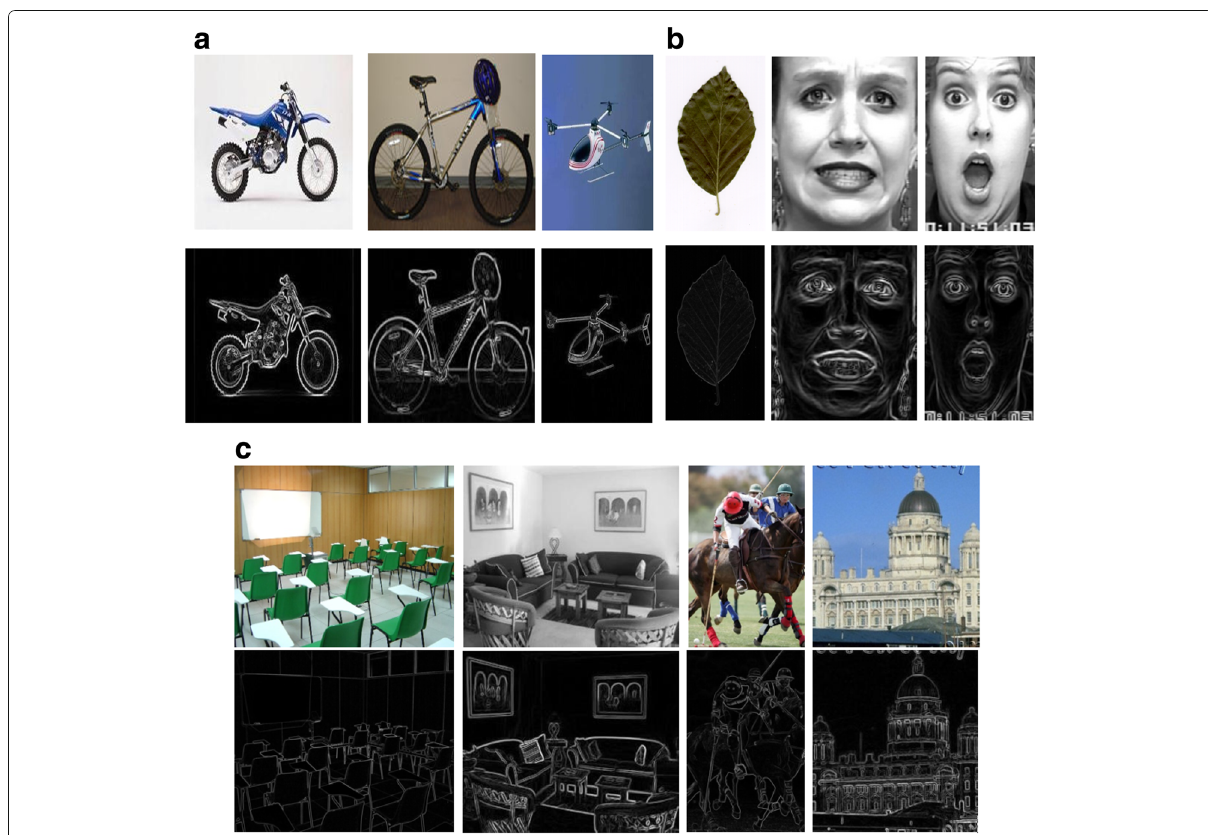
Fig. 4 Sample images with corresponding Sobel images from different categories of object, scene, and expression (first row original images and second row Sobel images). a Object classes. b Leaf and expression classes. c Scene classes